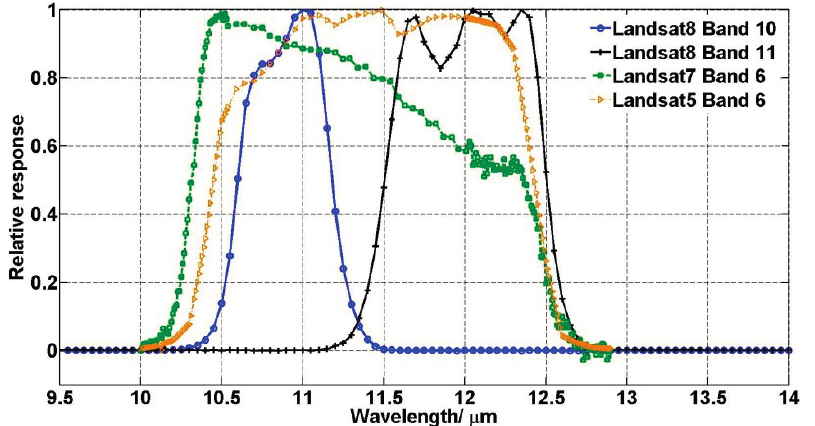
Figure 1. Relative Spectral Response for Landsat 5, 7 and 8 thermal